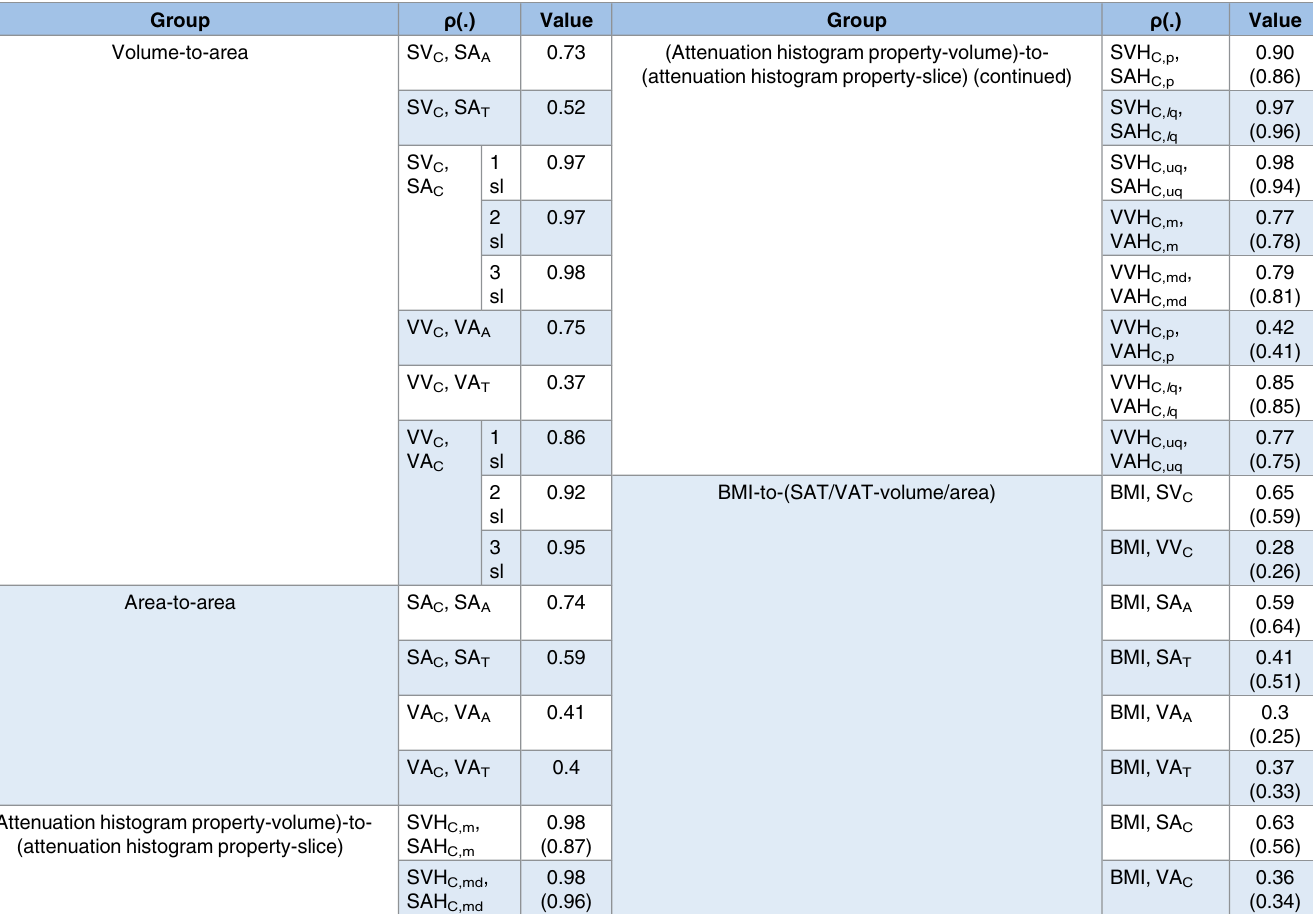
Table 4. Summaryof correlations from PCC. Attenuationhistogram property analysisand BMI-to-(SAT/VAT-volume/area) correlativeanalysiswith PCC (and SCC in parenthesis). Group ρ (.) Value Group ρ (.)